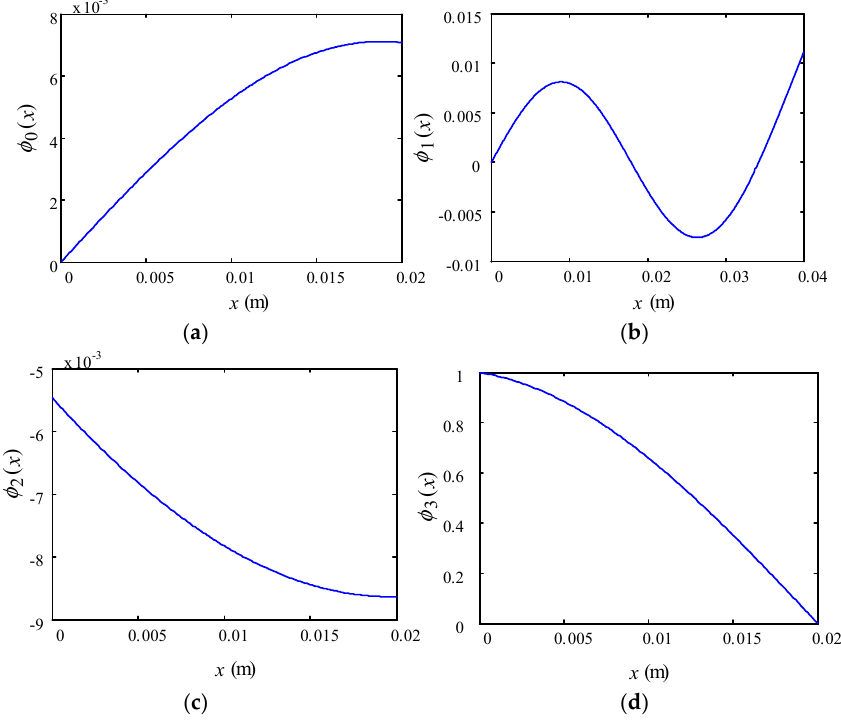
Figure 10. The 2nd order modal function. ( a ) Piezoelectric stack; ( b ) beam AB ; ( c ) beam BC ; ( d ) intermediate shaft DE .